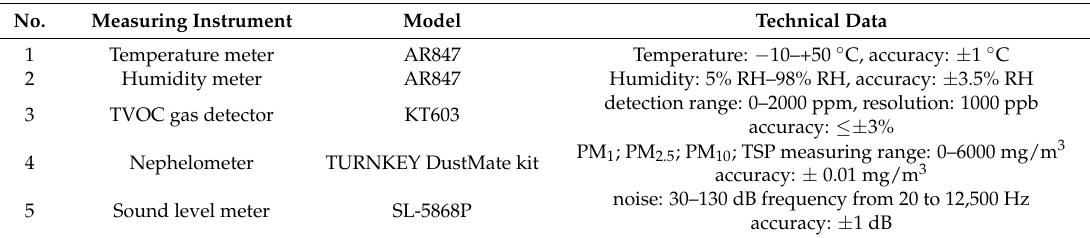
Table 2. Data about instruments used during IAQ